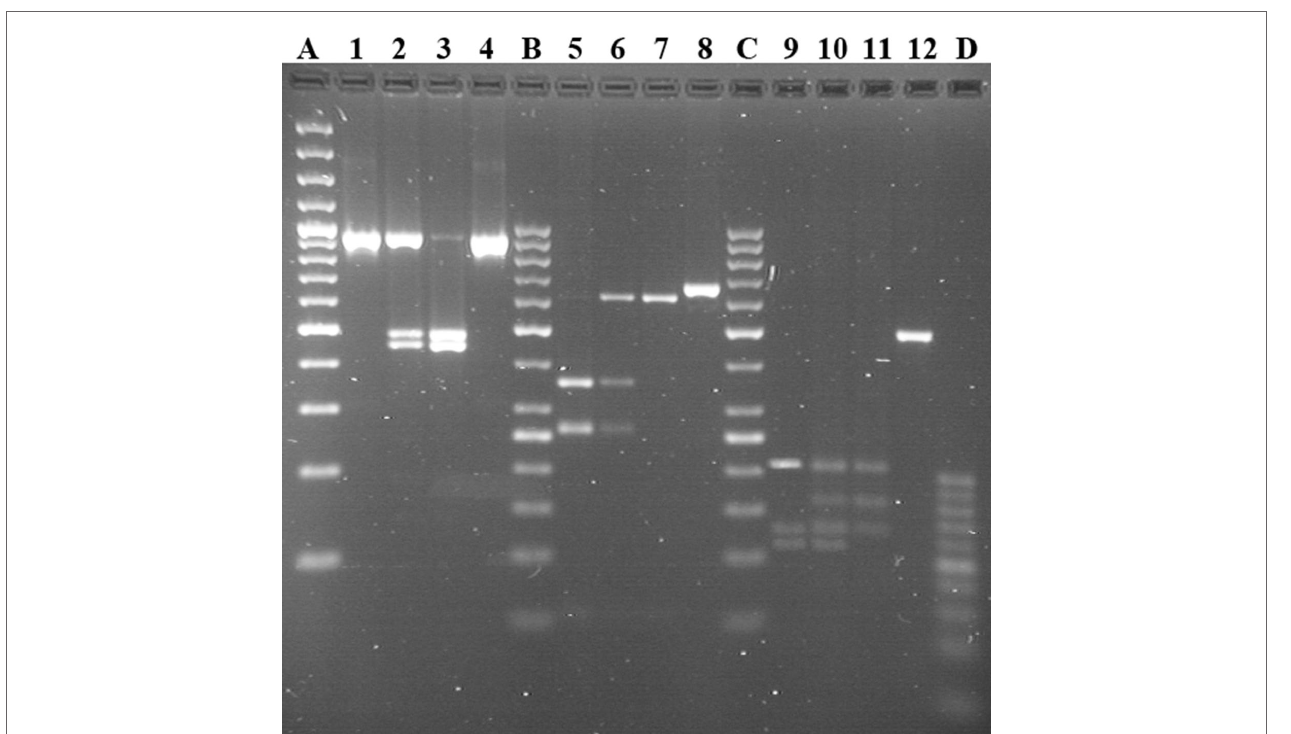
FIGURE 3 | Genotyping of CSN1S1 , CSN2 , and CSN3 by PCR-RFLP in Sudanese and Nigerian dromedary populations. Lines 1–4: locus CSN1S1 c.150G > T; genotypes TT, GT, and GG reported in lines 1, 2, and 3, respectively. Lines 5–8: locus CSN2 g.2126A > G; genotypes GG, AG, and AA reported in lines 5, 6, and 7, respectively. Lines 9–12: locus CSN3 g.1029T > C; genotypes CC, TC, and TT reported in lines 9, 10, and 11, respectively. Lines 4, 8, and 12 show undigested PCR products each belonging to the relative locus. Line A shows the GeneRuler™ 100 bp plus DNA Ladder (Thermo Scientific). Lines B and C show GeneRuler™